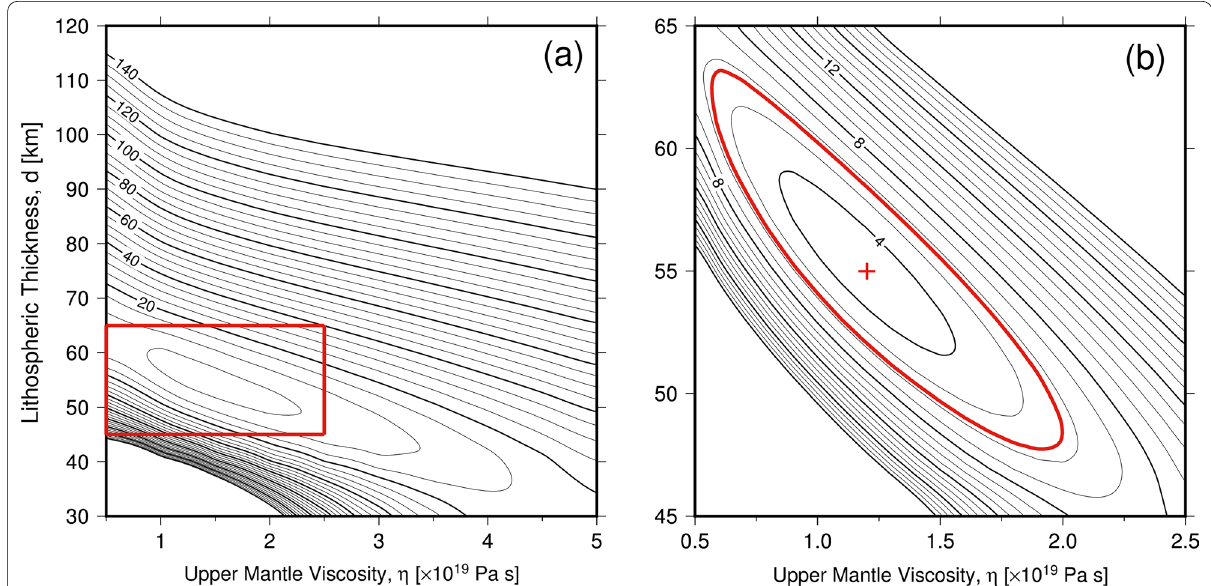
Fig. 7 Distribution of χ 2 to the variations of d and η in the incompressible case. The red area in panel ( a ) corresponds to the area shown in panel ( b ). In the panel b , the red cross indicates the position, where the χ 2 value reaches a minimum, and the red line indicates the 68.27 % confidence level of (η , d